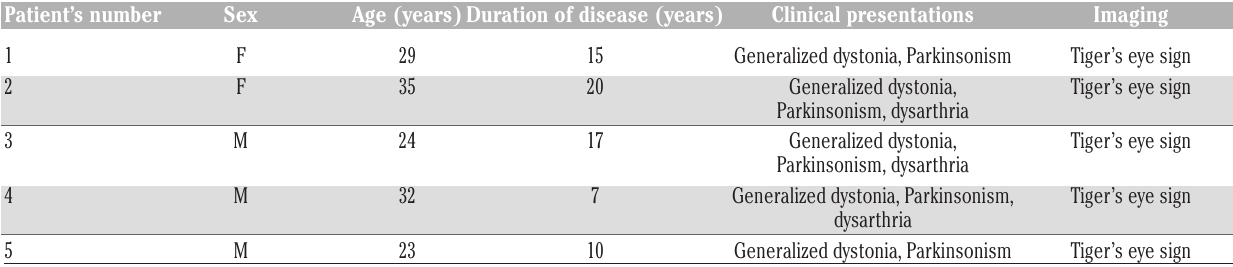
Table 1. Patients’ clinical presentations and imaging